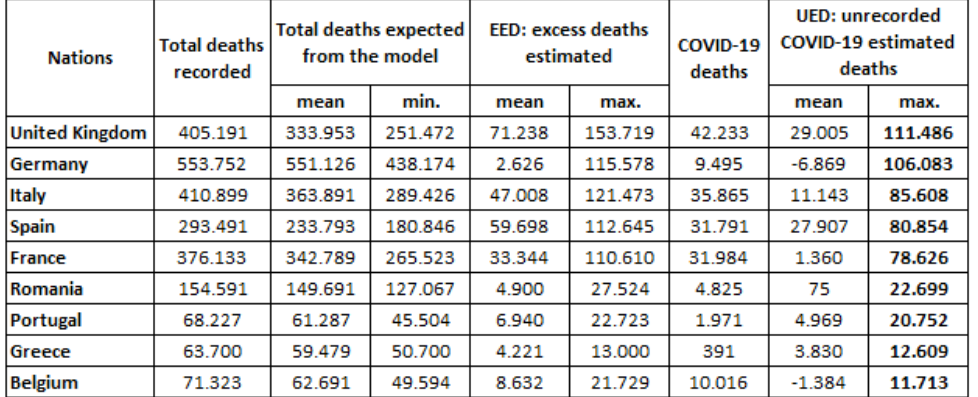
Table 8 shows the results obtained for each country in references to the period March-September 2020. Table 8. Results obtained from the analysis of the deaths recorded for each country (reference period March-September 2020)